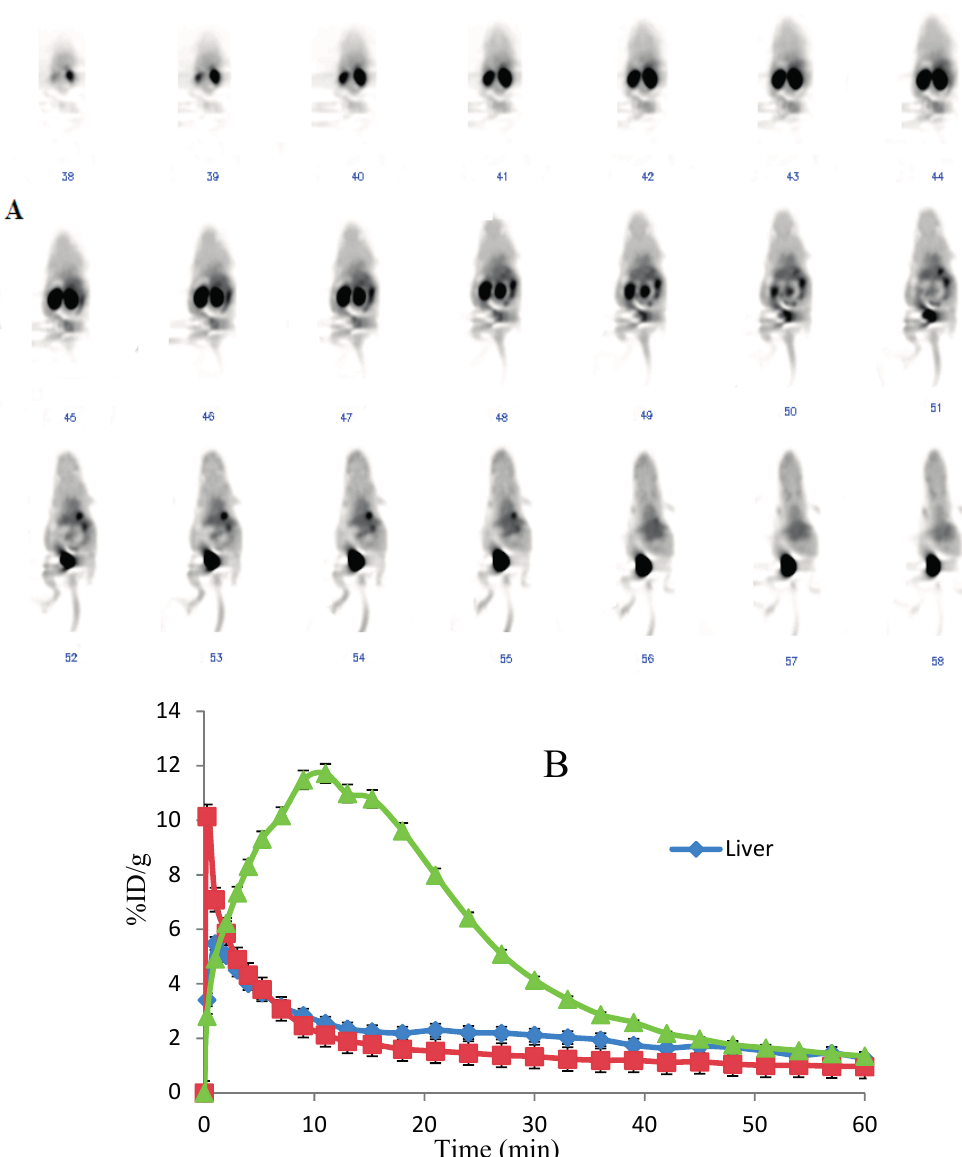
Figure 4. ( A ) Whole body coronal microPET images of ICR mouse from a 60 min dynamic scan after injection of 3.7 MBq 18 F-FBEM-Cys-Annexin V. ( B ) Quantified time-activity curves of major organs (liver, heart and kidney) after injection of 3.7 MBq 18 F-FBEM-Cys-Annexin V in normal ICR mice ( n =